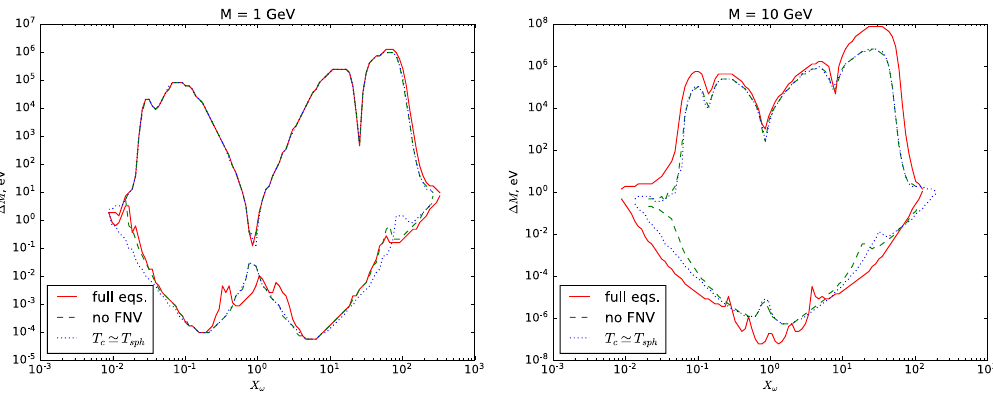
Figure 5 . Red, solid line — full kinetic equations (6.11). No fermion number violation — green, dashed lines. Blue, dotted lines correspond to an assumption, T EWPT in a number of previous works so far. Left panel , common mass M = 1 GeV. Right panel , common mass M = 10